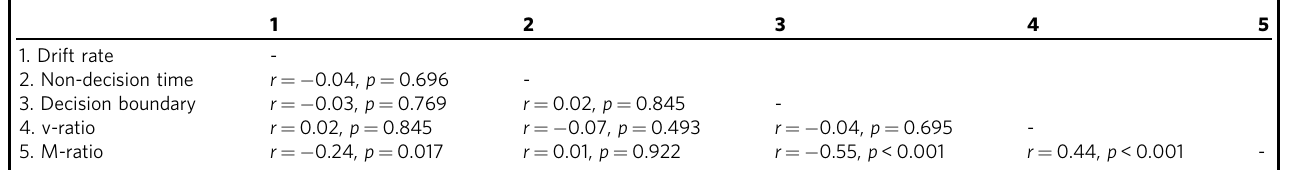
Table 1 Correlation table of the parameters from the model simulation, based on N = 100